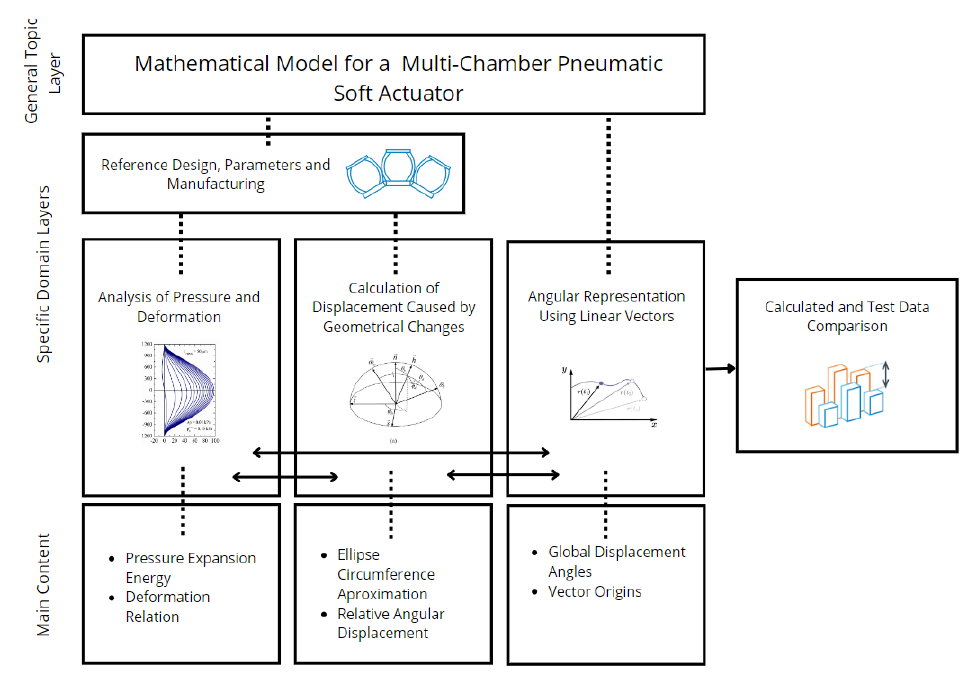
Figure 1. Research and Analysis Domain